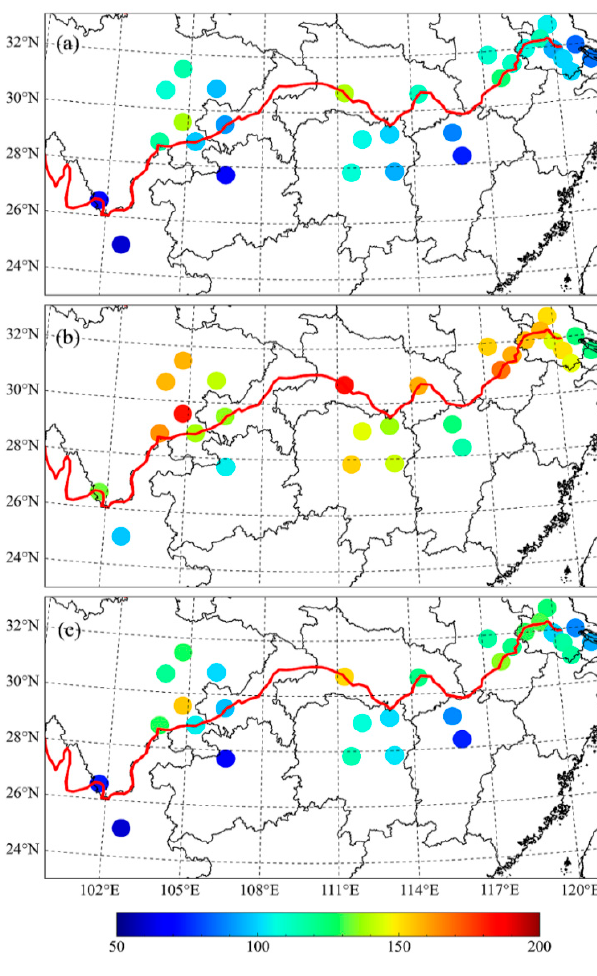
Figure 9. Wintertime average values of the ( a ) AQI, ( b ) AAQI, and ( c ) HAQI. Int. J. Environ. Res. Public Health 2020 , 17 , x